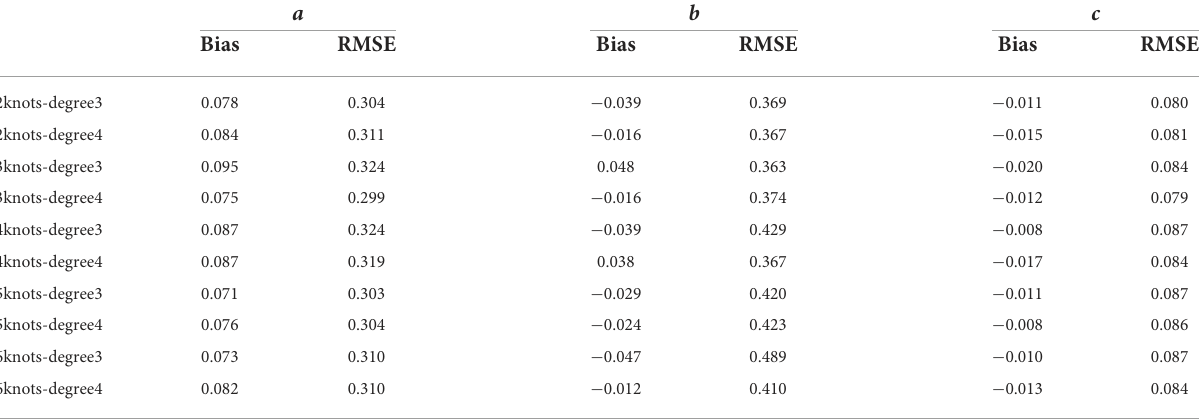
TABLE 4 Bias and RMSE of item parameter estimates under different combinations of knots and degree in bimodal case. a b c Bias RMSE Bias RMSE Bias RMSE